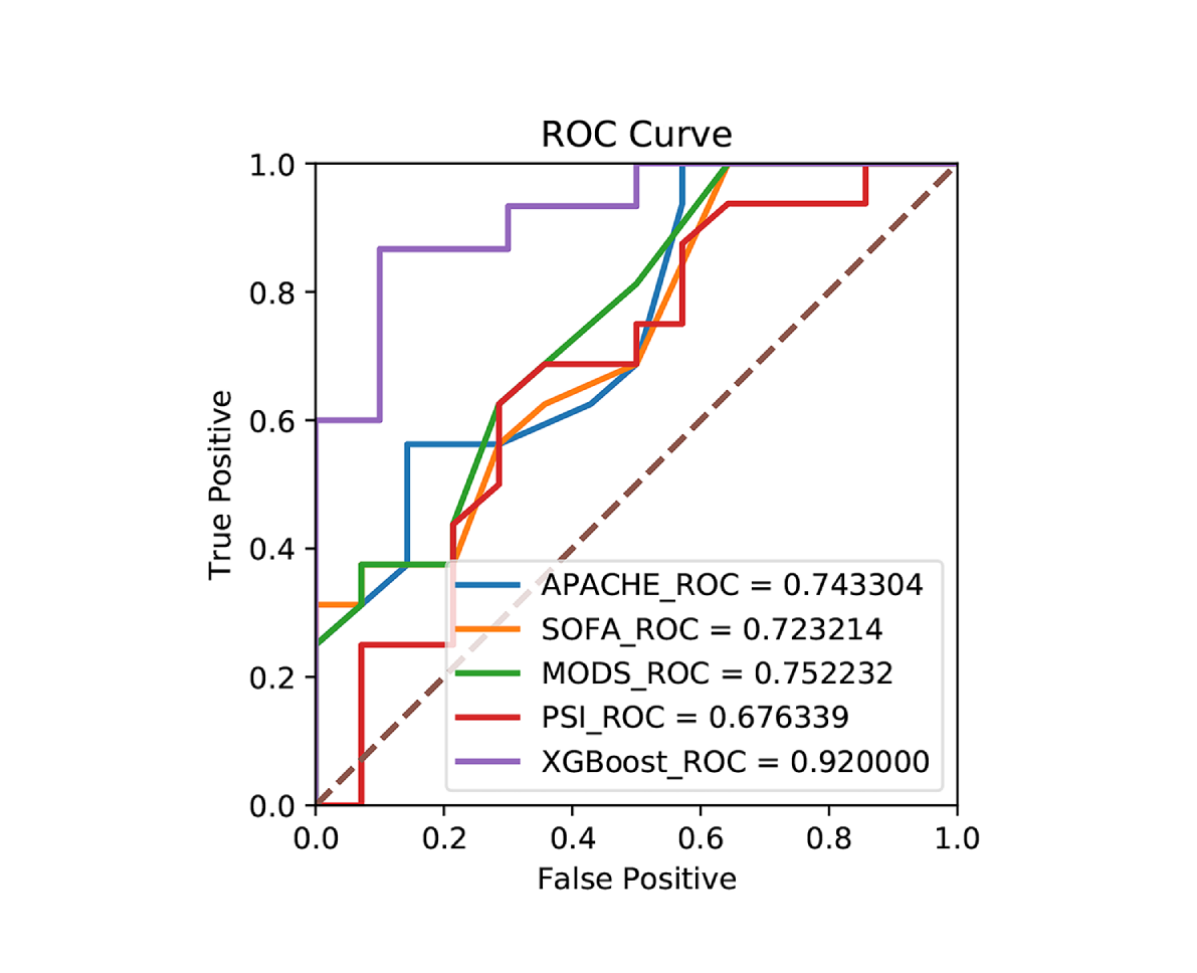
Figure 9. Comparison between the risk prediction model of the present study and the ROC curves of various critical scores. APACHE: Acute Physiologic Assessment and Chronic Health Evaluation; MODS: Multiple Organ Disfunction Score; PSI: Pneumonia Severity Index; ROC: receiver operating characteristic; SOFA: Sequential Organ Failure Assessment; XGBoost: eXtreme Gradient